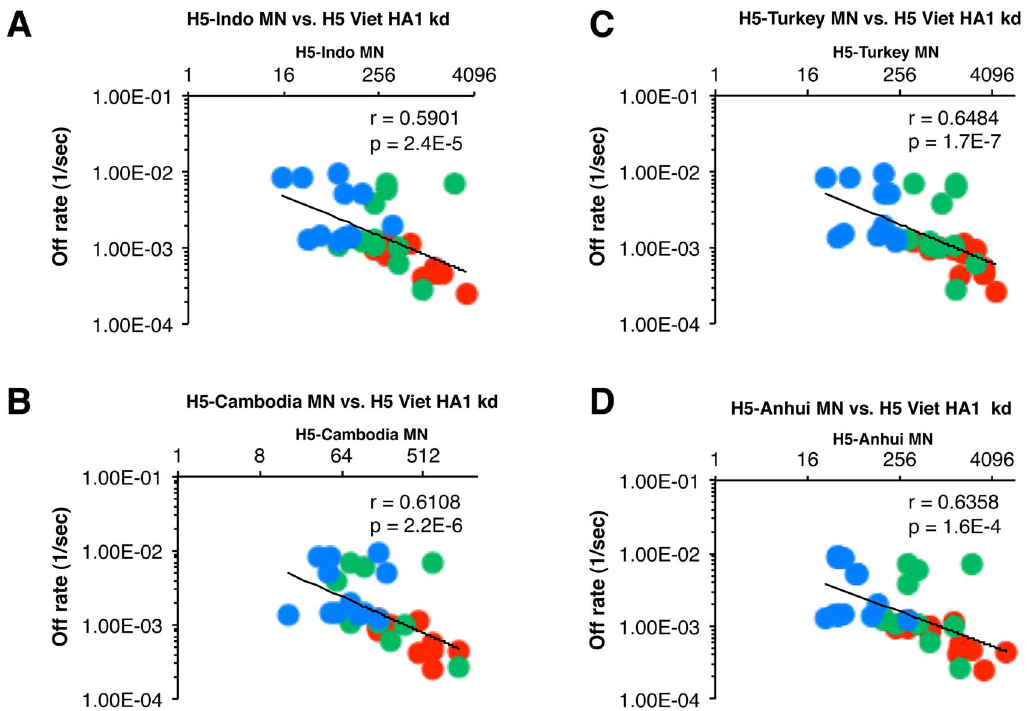
Figure 5. Serum antibody off-rates to H5-Viet-rHA1 (but not HA2) following prime-boost strongly correlates with the in-vitro cross- neutralizing capacity against diverse H5N1 strains. End-point neutralizing antibody titers of post-H5N1 vaccination sera are plotted on the X- axis. Antibody off-rate constants that describe the fraction of antibody-antigen complexes decaying per second were determined directly from the plasma sample interaction with rHA1 protein using SPR in the dissociation phase are shown on Y-axis. SPR analysis of post-boost vaccination human sera from responders (MN $ 1:40) of all vaccine groups included in the vaccine trial was performed with rHA1 of the H5N1-A/Vietnam/1203/2004 strain. Serum samples on day 21 following single MF-59-H5N1 booster vaccination from the MF59-H5N3 adjuvanted prime (red symbols) or unadjuvanted H5N3 prime (green symbols) or after two MF59-H5N1vaccinations in the unprimed control (blue symbols) vaccine group are shown. Antibody affinity of post-H5N1 vaccinated human sera against HA1 of H5N1-A/Vietnam/1203/2004 strongly correlated with the in-vitro heterologous cross-neutralizing MN titers against H5N1 clade 2.1- A/Indonesia/5/2005 (A), clade 1 variant- A/Cambodia/R04050550/2007 (B), clade 2.2- A/Turkey/ 15/2006 (C), and clade 2.3.4- A/Anhui/1/2005 (D)